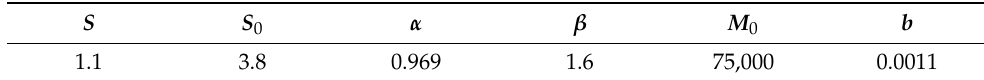
Table 5. Material parameters.